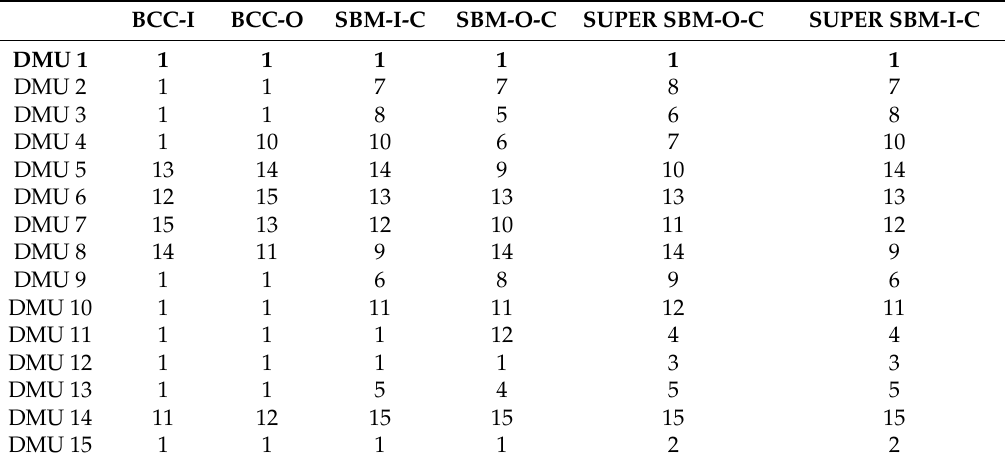
Table 15. The results of DEA